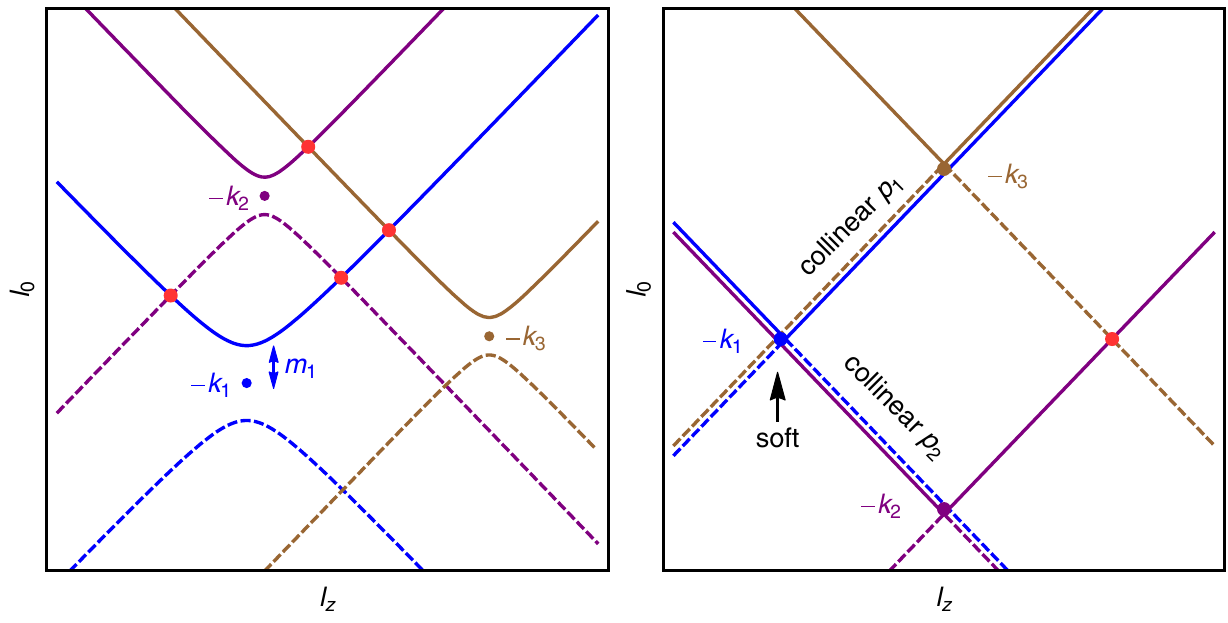
Fig. 2 On-shell hyperboloids for three arbitrary propagators in Cartesian coordinates in the ( (cid:2) 0 , (cid:2) z ) space ( left ). Kinematical configuration with massless propagators leading to infrared singularities ( right ). In the latter case, the on-shell hyperboloids degenerate to light-cones